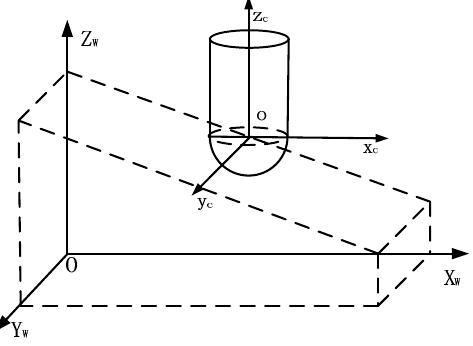
Figure 9. Workpiece and tool coordinate system [20].